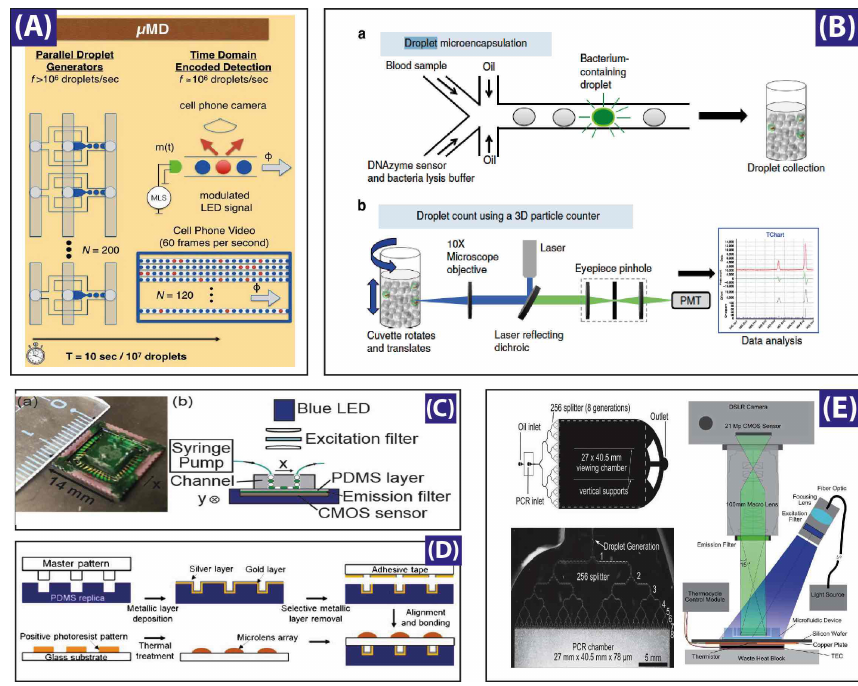
Figure 5. Different studies for droplet generation monitoring: ( A ) A microdroplet megascale detector ( µ MD) containing a micro-controller-based light emitting diode, a microfluidic